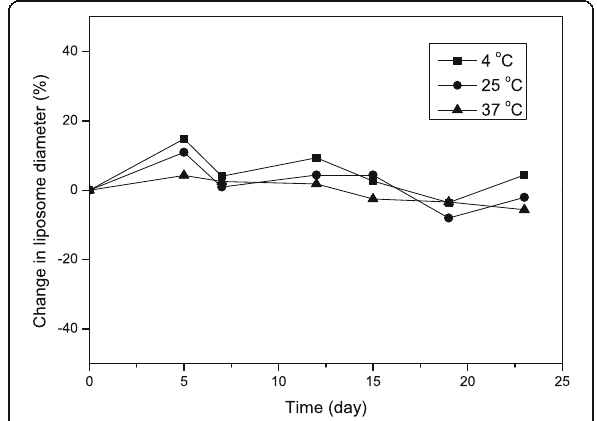
Fig. 7 Stability of dual drug-encapsulated nanoliposomes incubated in PBS (pH 7.4) at different temperatures of 4, 25, and 37 °C, respectively: percent change in nanoliposome diameter relative to initial diameter as a function of incubation time